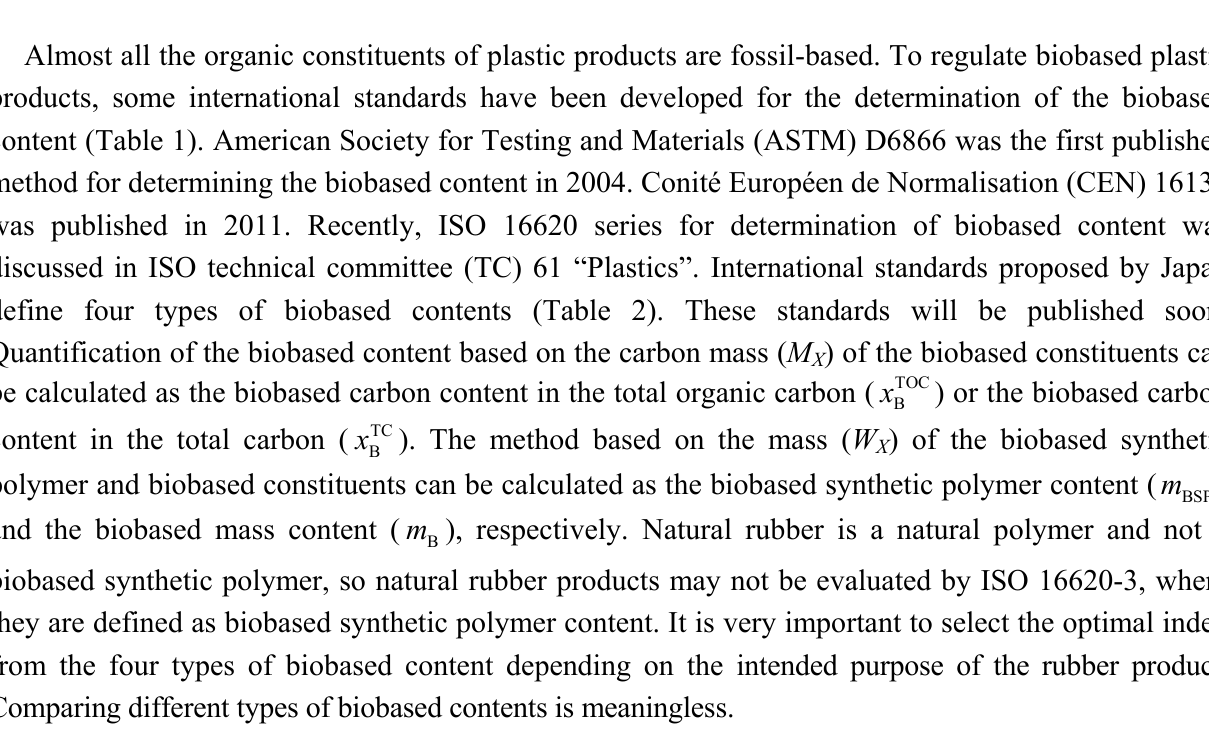
Table 1. International standards that define biobased